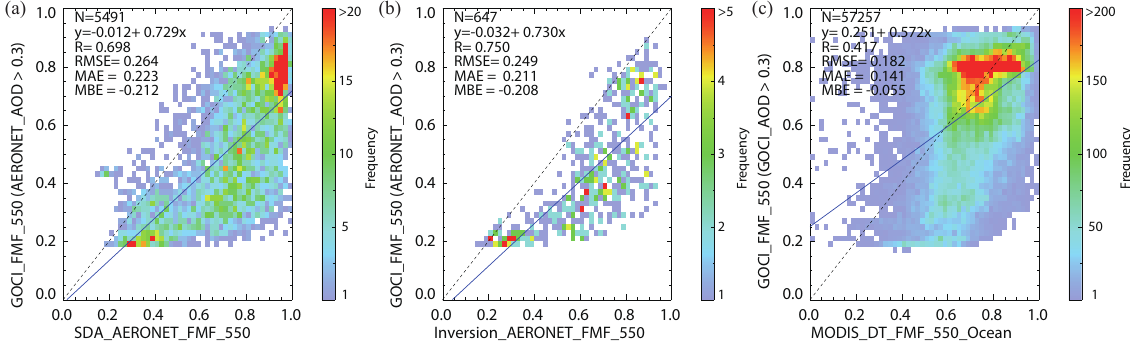
Figure 11. Comparison of FMF between (a) SDA AERONET and GOCI, and (b) inversion AERONET and GOCI only for AERONET AOD >0.3. (c) FMF intercomparison between MODIS DT and GOCI over ocean only for GOCI AOD >0.3. Colored pixels represent a bin size of 0.05. Dashed and solid lines denote the same as Fig.